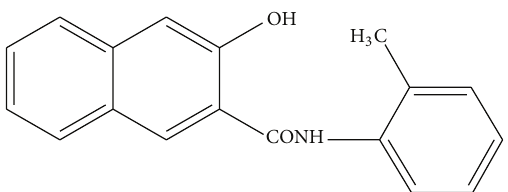
Figure 2: Structure of 3-hydroxy-2-carboxylic acid 2-methyl- anilide (Naphthol